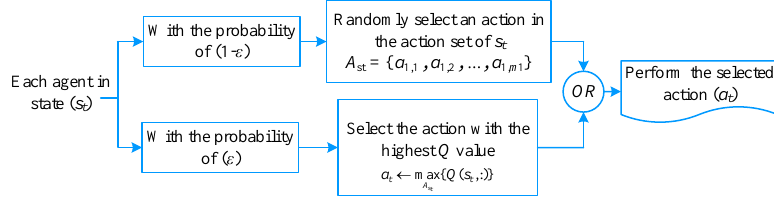
Figure 3. The ε -greedy mechanism for selecting the proper